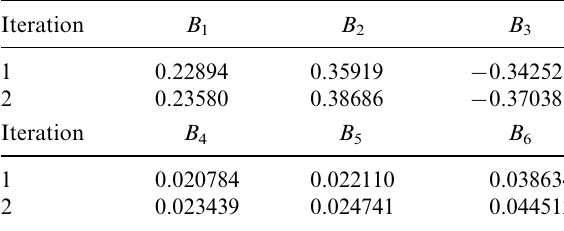
Table 4. Calculated response surface coefficients Iteration